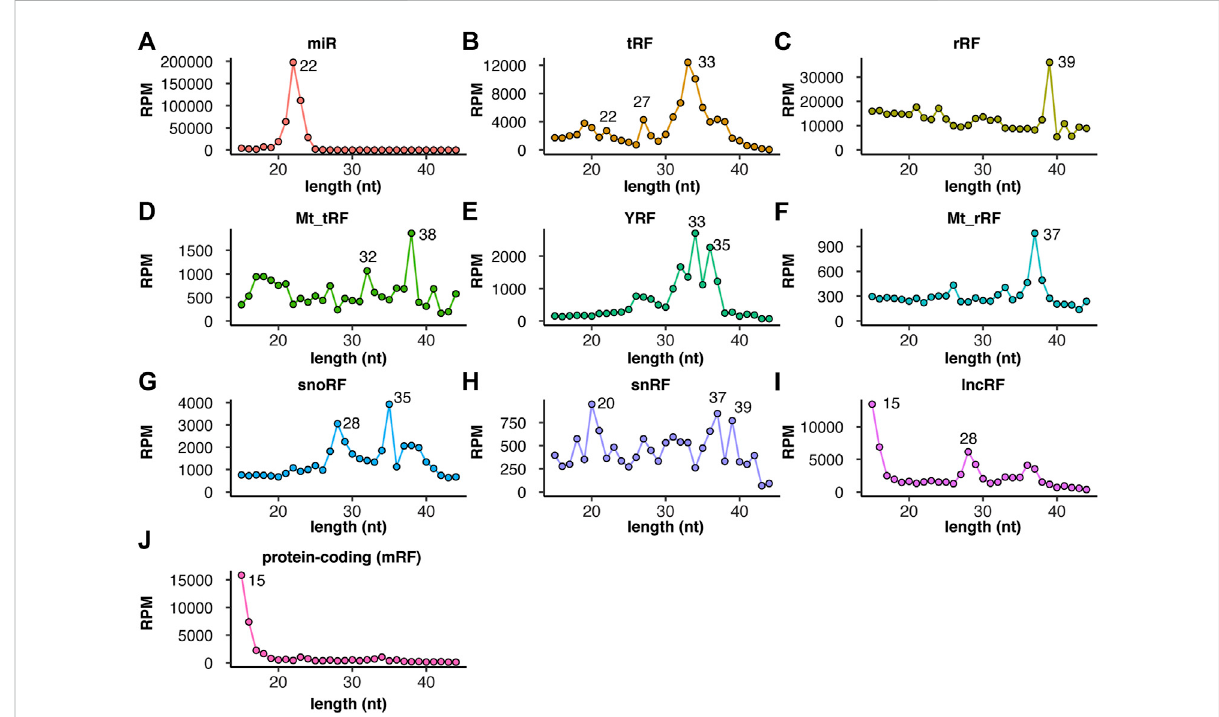
FIGURE 2 microRNAs and non-microRNA small RNAs show distinct size distribution. Size distribution ( X -axis in nucleotides, Y -axis in reads per million mapped reads) of eachsubtype ofsmall RNAs including (A) microRNAs, (B) tRFs, (C) rRFs, (D) mitochondrialtRFs, (E) YRFs, (F) mitochondrialrRFs, (G) snoRFs, (H) snRFs, (I) lncRFs and (J) mRFs. Major peaks in length are labeled for each small RNA subtype. RPM values are averaged from 12 samples (individual samples plotted in Supplementary Figure